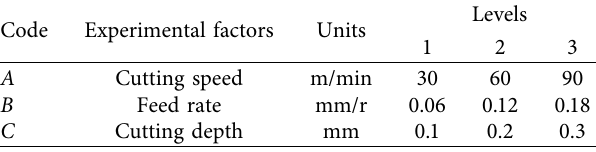
Table 3: Chosen parameters and levels.